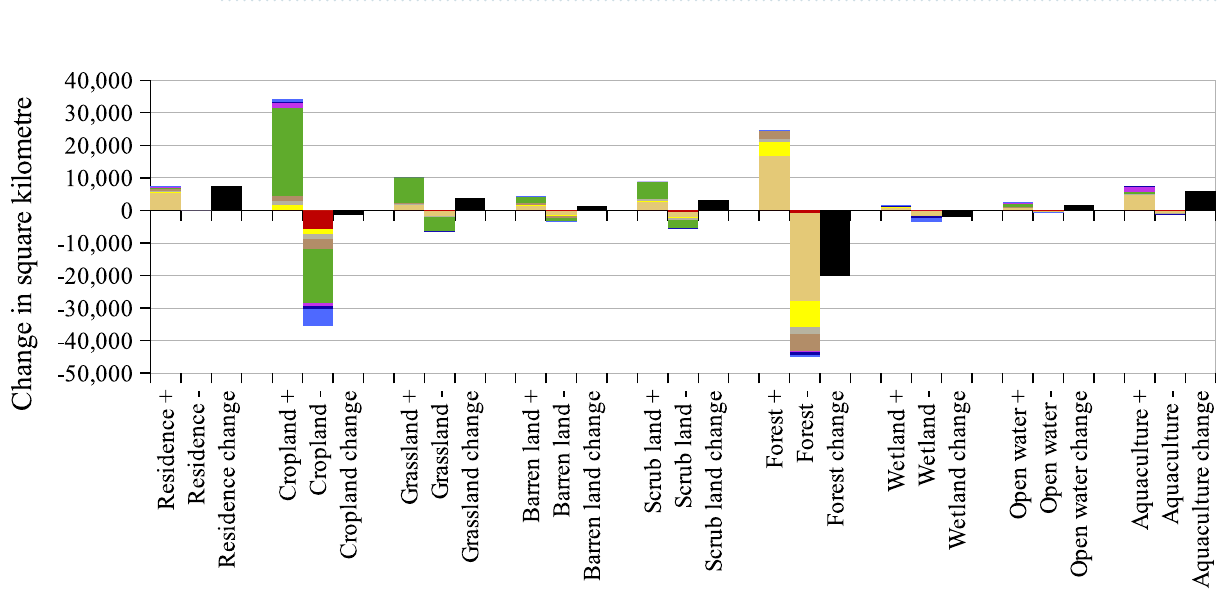
Figure 7. LULC gain/loss and conversions between 1990 and 2020; “ + ” means gain and “-” means loss in area (km 2